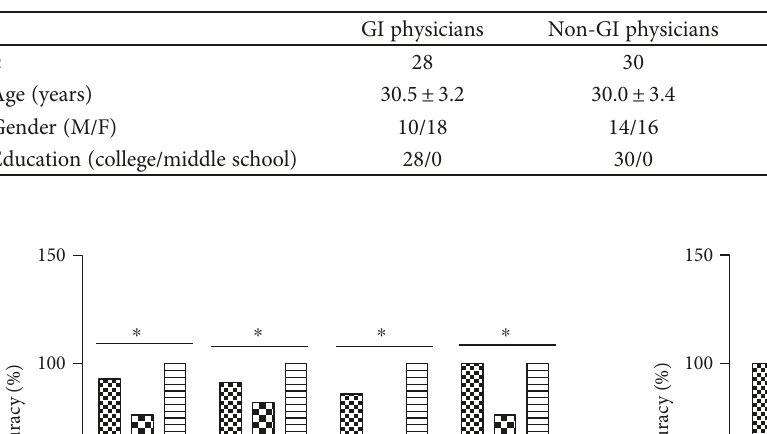
Table 1: Characteristics of the subjects.